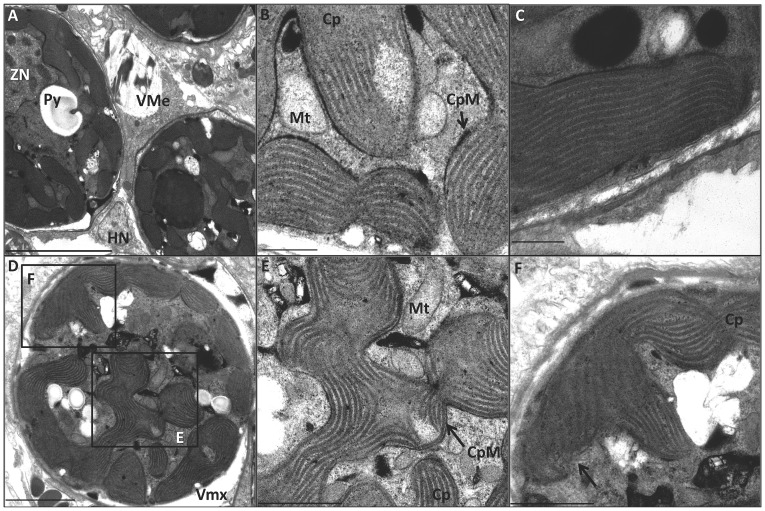
Transmission electron micrographs of a zooxanthella within the endodermal layer of the host coral P. damicornis exposed to 400 µµµµµmoles/meter2/second PAR peak irradiance (low-light) at 25°C and 32°C.Cp = chloroplast; CpM = chloroplast membrane; HN = host nucleus; MT = mitochondria; Py = pyrenoid body; T = thylakoids; VMe = host vacuolar membrane; Zn = Zooxanthella nucleus. (A) Low-light at 25°C (reference treatment). Magnification 1500×, Scale bar = 5000 nm. (B) Magnified area from boxed area in A. Magnification 8000×, scale bar = 500 nm. (C) Low-light at 25°C, magnified view of thylakoids in the chloroplast. Magnification 8000×, scale bar = 500 nm. (D) Low-light at 32°C. Magnification 2500×, scale bar = 2000 nm. (E) Magnified area from boxed area in D. Magnification 6000×, scale bar = 1000 nm. Arrow indicates intact trilaminate chloroplast membrane. (F) Magnified area from boxed area in D. Magnification 6000×, scale bar = 1000 nm. Arrow indicates diffused and disorganized chloroplast membrane zone.